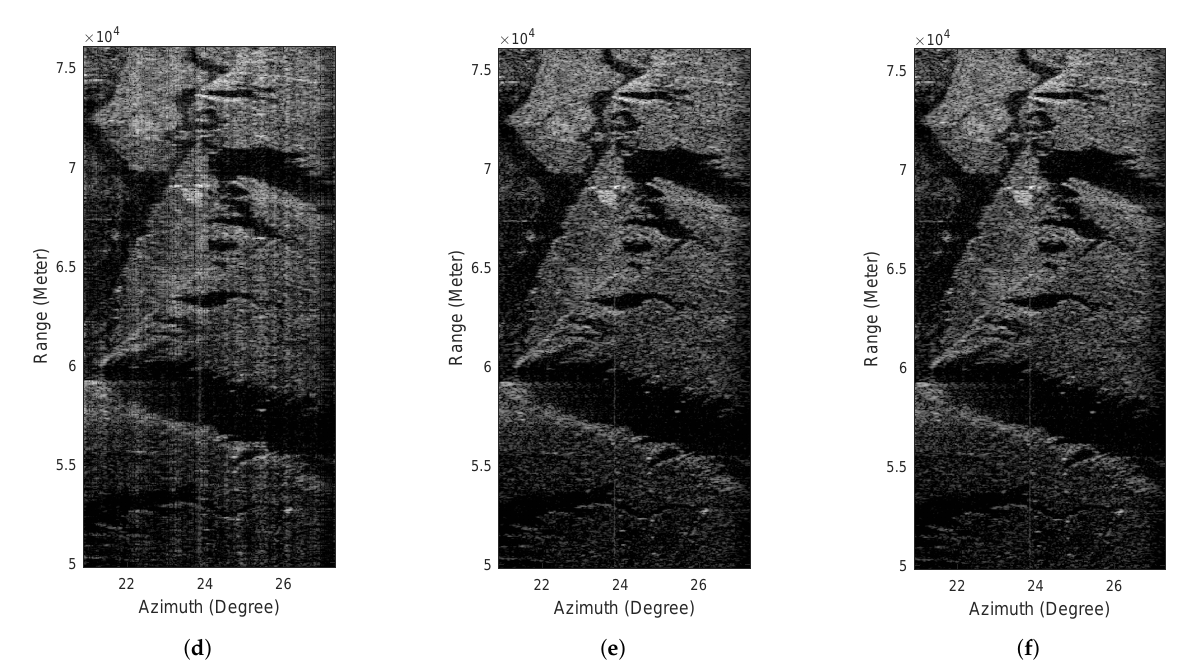
Figure 8. Real data 2 results. ( a ) Real-beam echo, ( b ) TSVD, ( c ) IAA, ( d ) Sparse, ( e ) TV, ( f ) GSFTV.